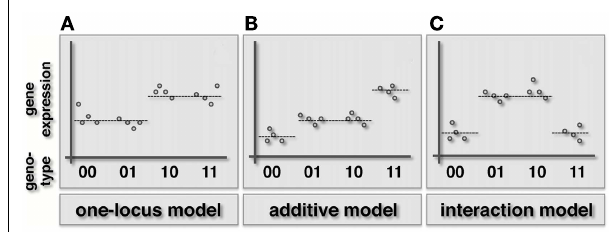
FIGURE 1 | Schematic illustration of the one-locus, additive and epistatic effects models in haploid organisms. Specifically, we represent the combined genotype of the pair of loci on the x -axis, while the expression level of the underlying gene is shown on the y -axis. (A) In the one-locus model the genotype of one locus (here the first in the pair) drives the given phenotype. (B) In the additive model both loci contribute to the phenotype in an additive way. (C) When an epistatic interaction occurs, the effect of the two loci on the trait is non-additive.